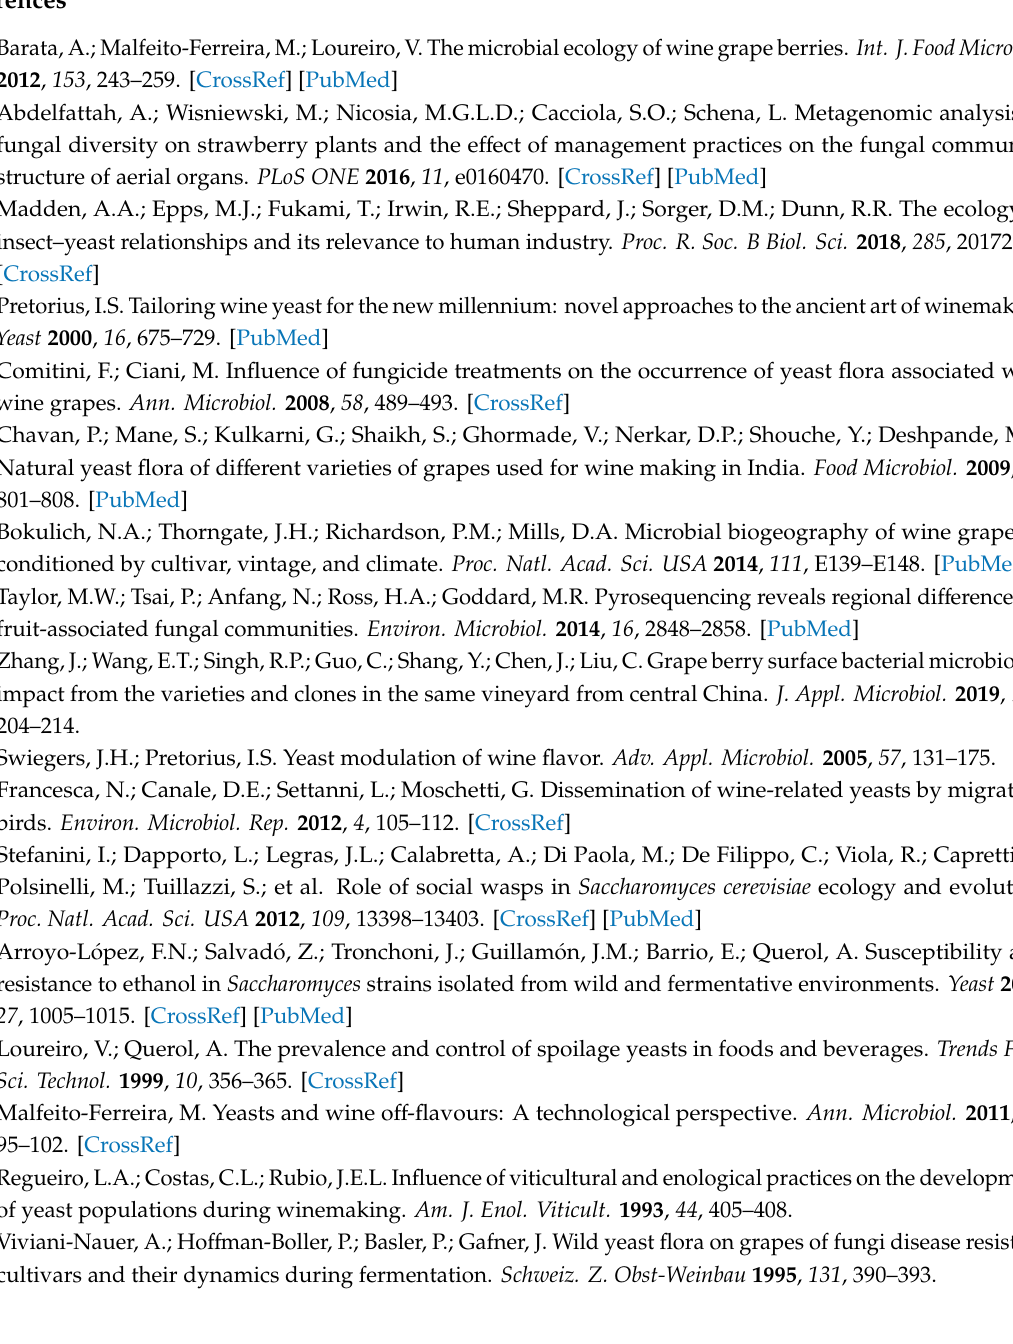
Table S1: Analysis of variance (ANOVA) of filamentous fungi detected by NGS in Montepulciano samples at harvest time and at the 7th and 15th day of microfermentation carried out using aseptically pressed grapes. Table S2: Analysis of variance (ANOVA) of yeast species detected by culture-dependent method in Montepulciano samples at harvest time and at the 7th and 15th day of microfermentation carried out using aseptically pressed grapes. Table S3: The main analytical compounds of Montepulciano microfermentations carried out using aseptically pressed grapes. Table S4: Analytical results of organic (MO), conventional (MC) and not treated (MNT) Montepulciano